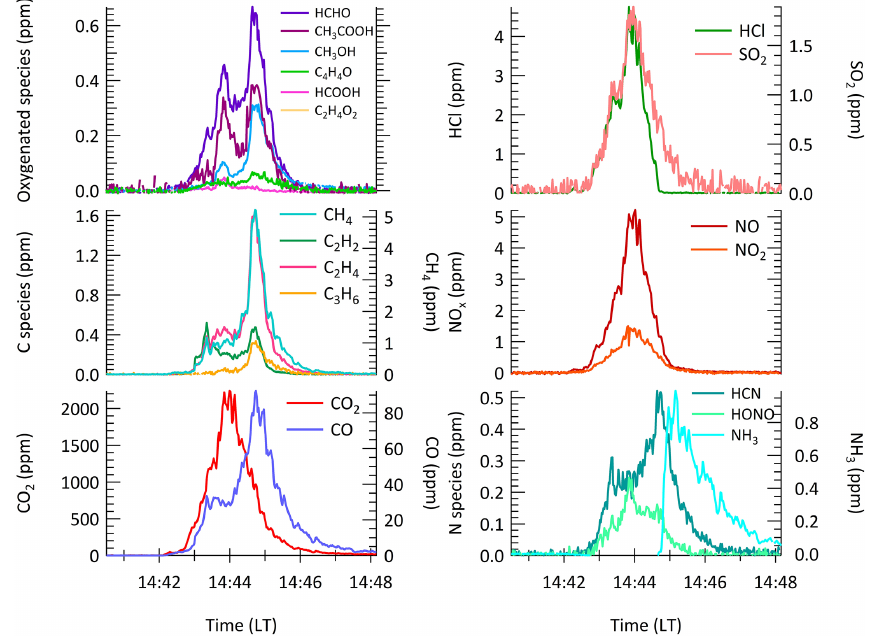
Figure 2. Excess mixing ratios of 19 trace gases vs. time for a complete sawgrass “stack” burn as measured by OP-FTIR.